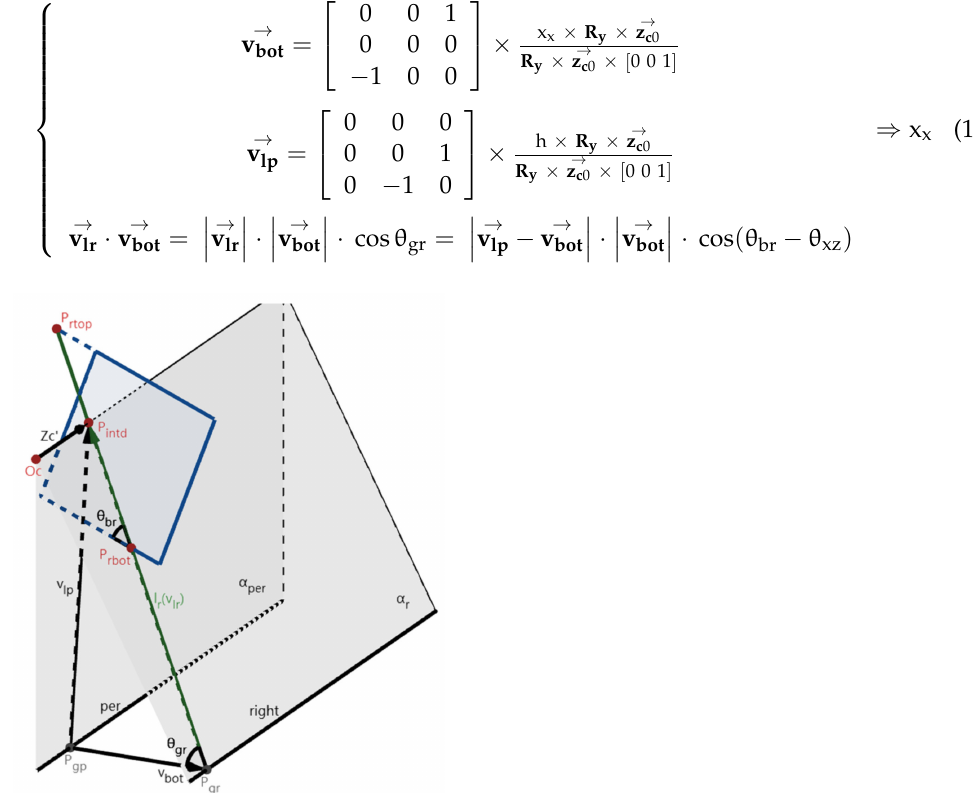
Figure 12. The imaging for the calculation of x x . The right lane l r is detected in the IMG